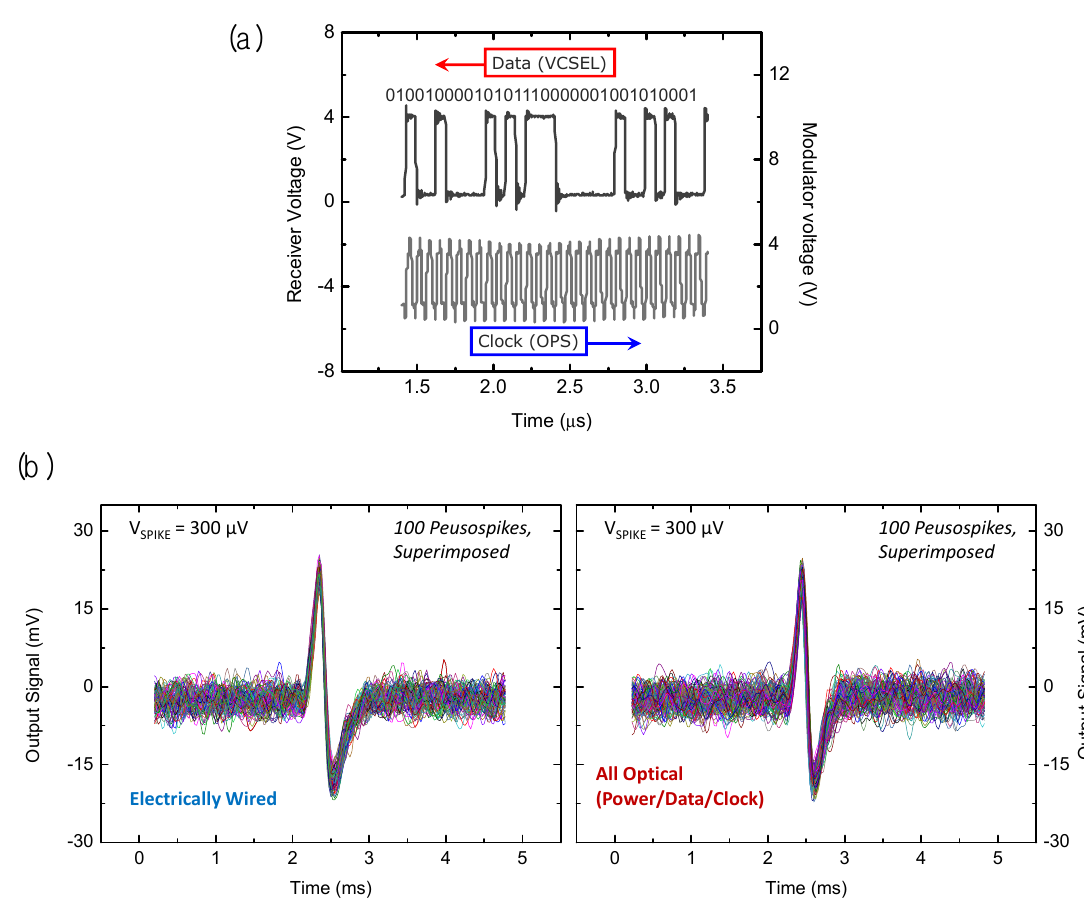
Figure 7. Bench top testing of the all-optical neural sensing microsystem; ( a ) optical digital data segment from a portion of a spike event (top) and the corresponding clock sampling trace (bottom); ( b ) comparison of system performance using a pseudospike recording test in a saline bath. A 300 μ V bipolar spike signal is measured by the all-optical telemetry/power system (right panel) and a system with electrically wired telemetry and power links (left